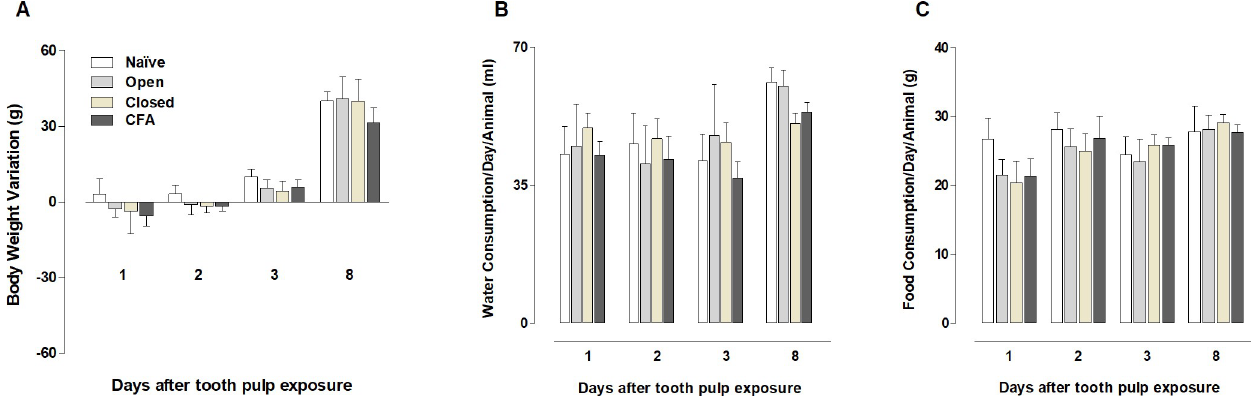
Fig 4. Body weight variation (A), water (B) and food (C) consumption per animal/day in the different experimental groups. The columns represent the mean of 5–7 experiments, and the vertical lines indicate the standard error of mean. (P > .05; Kruskal-Wallis plus Dunn’s